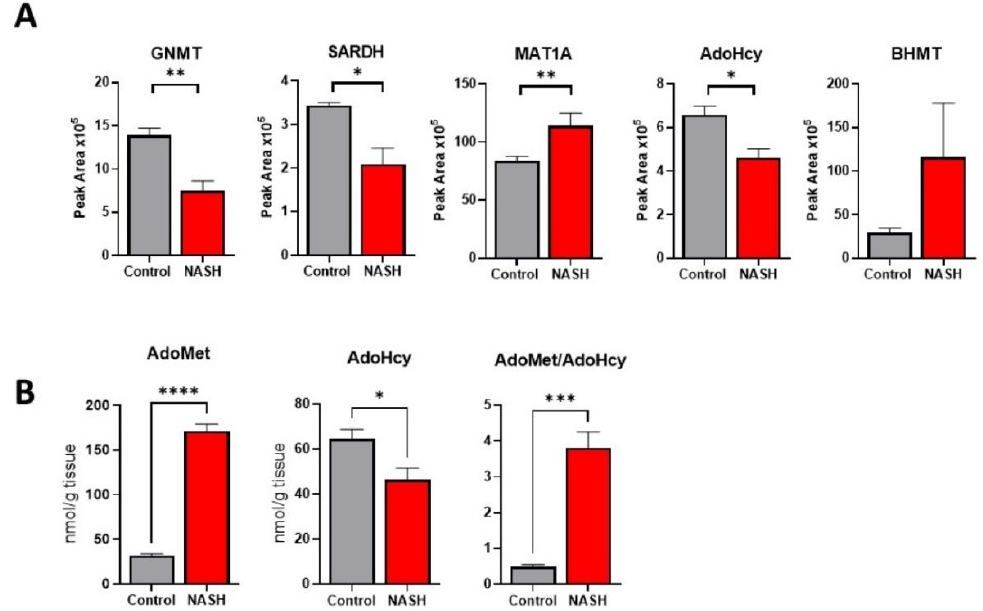
Figure 5. Dysregulation of AdoMet metabolism in NASH. ( A ) Relative protein abundance of select AdoMet regulating enzymes in control and NASH livers. ( B ) Levels of liver AdoMet and AdoHcy in control and NASH mice. Data presented as mean ± SEM (N = 4, **** p < 0.0001, *** p < 0.001, ** p < 0.01, * p < 0.05).